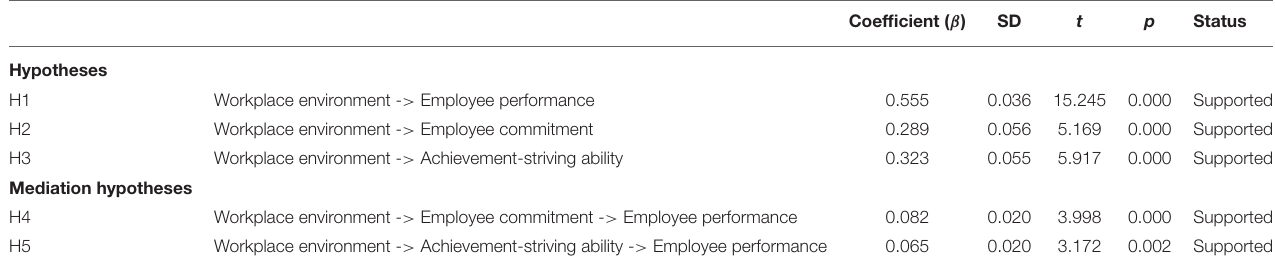
TABLE 8 | Hypotheses